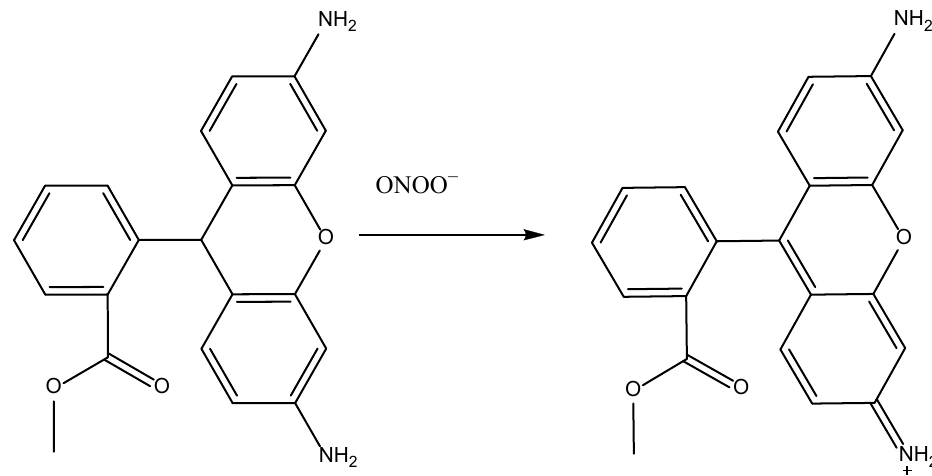
Figure 19. Peroxynitrite reaction with dihydrorhodamine (DHR) [58].